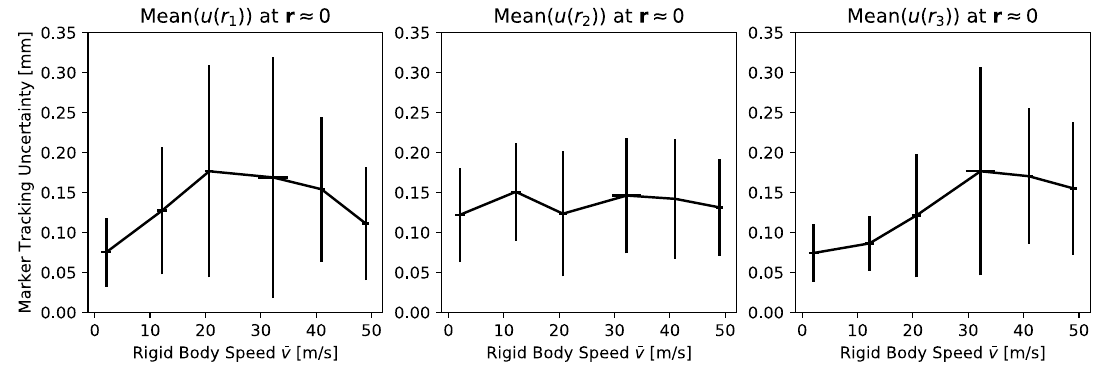
Figure 4. The three components of mean marker tracking uncertainty plotted versus mean rigid body speed. Error bars represent ±1 SD both, horizontally and vertically. All variables evaluated at imaginary tee